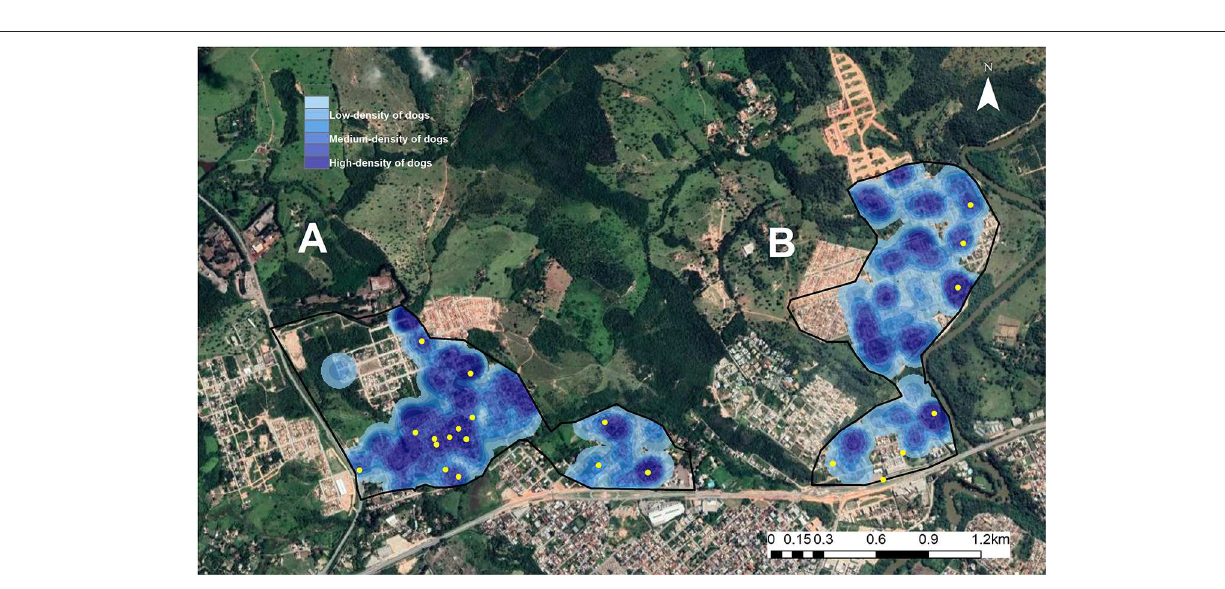
FIGURE 2 | (A,B) Spatial analysis of two areas of Divinópolis, MG, Brazil, showing the locations where free-roaming dogs congregated. Areas with a high-density of dogs are shaded dark blue, medium-density areas are mid blue and low-density areas are light blue. Yellow dots indicate the locations where commercial food outlets were